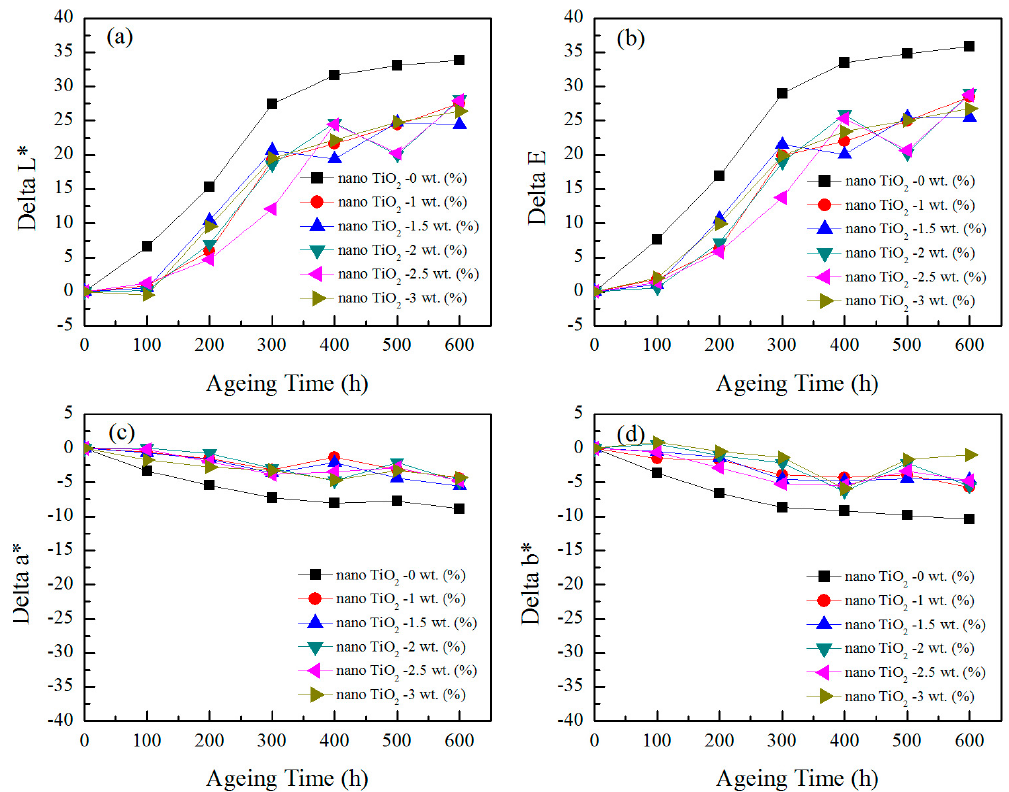
Figure 8. The change in color of foamed wheat straw fiber/PP composites with different modified TiO 2 nanoparticle content after UV weathering.